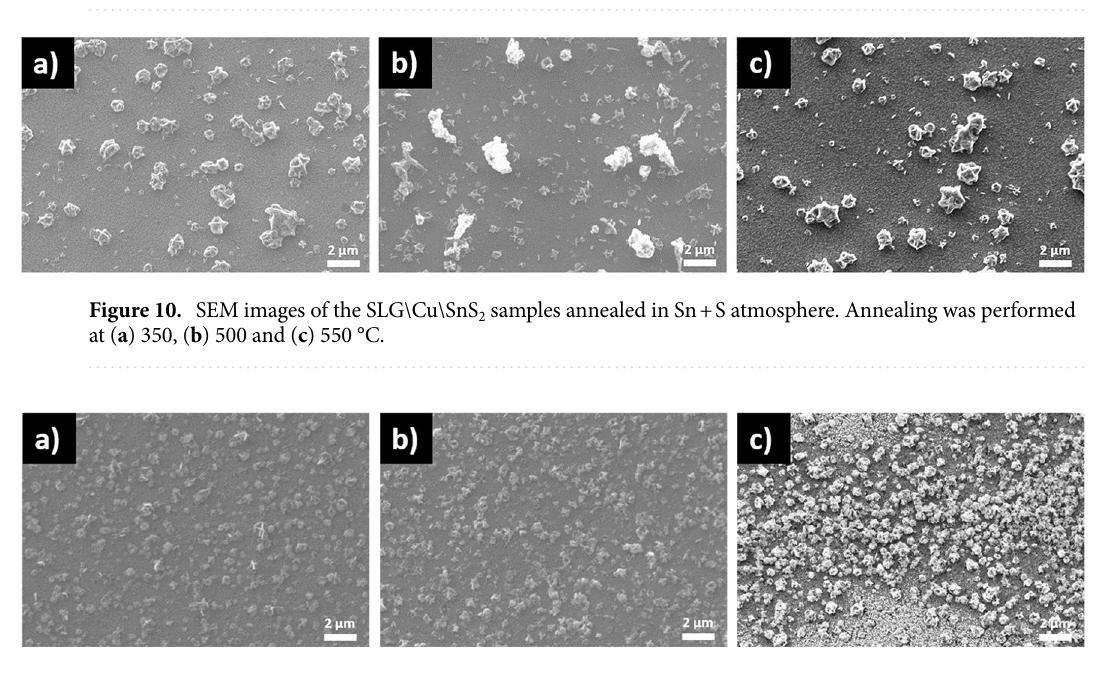
Figure 11. SEM images of the SLG\SnS 2 \Cu samples annealed in Sn + S atmosphere. Annealing was performed at ( a ) 350, ( b ) 500 and ( c ) 550